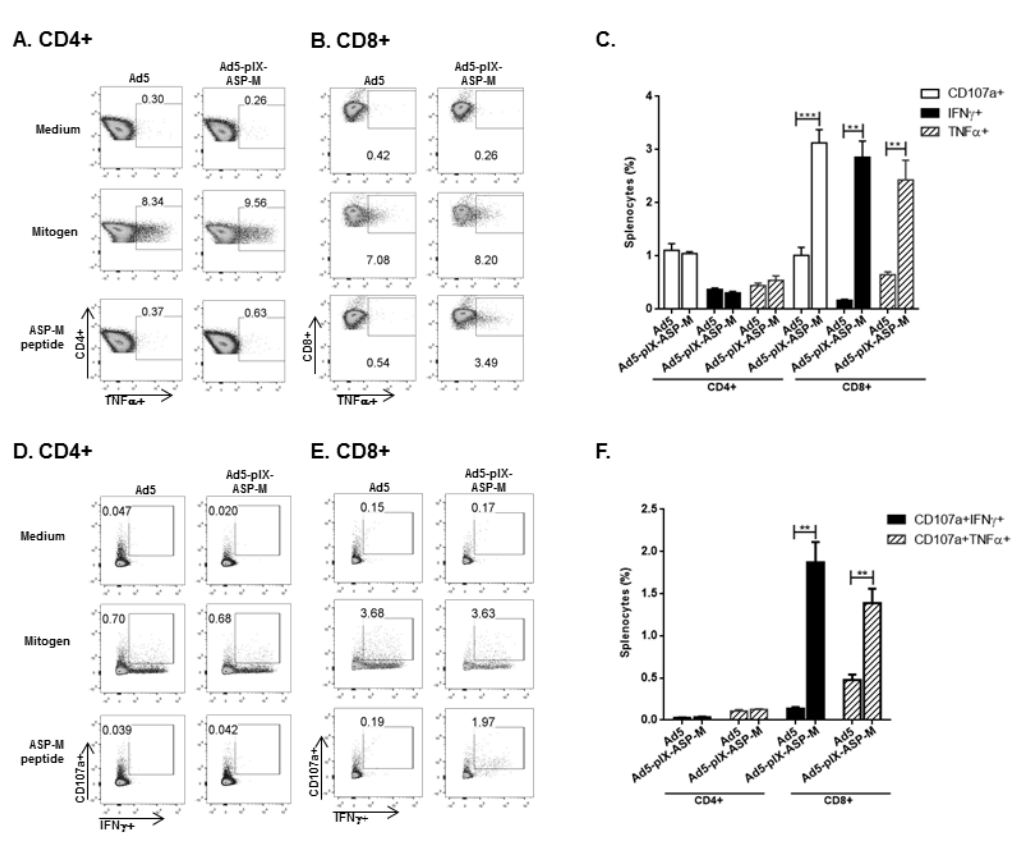
Figure 4. Frequencies of ASP-specific T-cell responses in immunized mice. Representative flow cy- tometric analysis of intracellular staining for IFNγ and TNFα production by ASP-M-specific CD4 + and CD 8 + T-cells memory cells. C3H/He mice were immunized with Ad5 or Ad5-pIX-ASP-M as described in Materials and Methods. Two weeks after the last immunization, splenocytes harvested from a subset of mice were stimulated with anti-CD107a and GolgiStop in the presence or absence of ASP-M peptide. After 6 hours, cells were incubated with anti-CD3, anti-CD4, and anti-CD8. Next the cells were permeabilized and fixed, then stained with anti-TNFα, and anti-IFNγ. Cells were gated by side scatter area (SSC-A); forward scatter area (FSC-A); and gated for CD3 + CD4 + or CD 3+ CD⁸ + T lymphocytes. (A): Representa- tive flow cytometry plots of TNFα + by CD4 + T cells from the spleens of the immunized mice; (B): Rep- resentative flow cytometry plots of TNFα + by CD8 + T cells from the spleens of the immunized mice; (C): Histogram showing the percentage of CD107a + , INFγ + , TNFα + production. The numbers represent the frequencies of cells stained for CD4 + INF + , CD4 + TNFα + or CD8 + INF + , CD8 + TNFα + . The results are present- ed as the mean ± SEM frequencies of CD4 + or CD8 + cells for 4 mice. (**) = P < 0.01 and (***) = P < 0.001. (D): Representative flow cytometry plots of CD107a + IFNγ + produced by CD4 + T cells from the spleens of the immunized mice; (E): Representative flow cytometry plots of CD107a + IFNγ + produced by CD8 + T cells from the spleens of the immunized mice; (F) Histogram showing the percentage of CD107a + IFNγ + and CD107a + TNFα + production. The results are presented as the mean ± SEM frequencies of CD4 + or CD8 + cells for 4 mice. (**) = P <